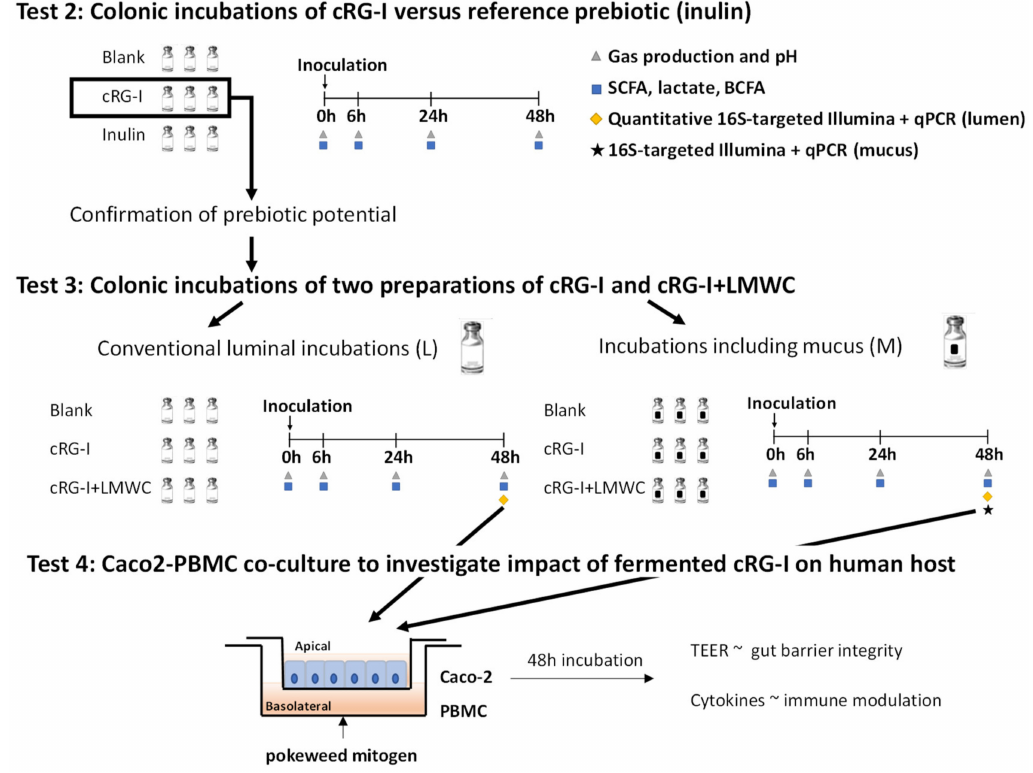
Figure 1. Schematic representation of the integrated in vitro approach to investigate the prebiotic potential of cRG-I (carrot-derived rhamnogalacturonan-I). First, potential digestion of cRG-I by amylase / brush border enzymes was investigated (Test 1). In Test 2, short-term colonic batch incubations were used to assess the prebiotic potential on microbial metabolic activity of cRG-I compared to inulin. In Test 3, the prebiotic potential of two formulations that di ff ered in absence (cRG-I) or presence of low molecular weight carbohydrates (cRG-I + LMWC) was assessed in both conventional luminal incubations (L) and incubations including a mucosal compartment (M). Samples were collected to evaluate the e ff ect of the test products on microbial activity, community composition and on intestinal permeability and immunity (Test 4, Caco-2 / PBMC co-culture